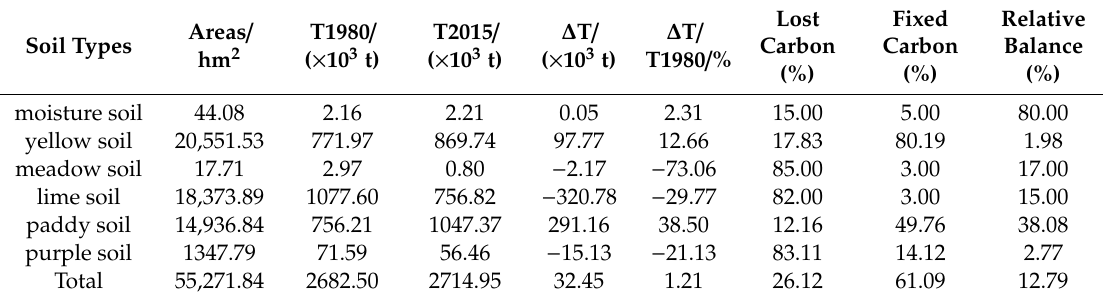
Table 6. Changes of SOC storage in surface soil of farmland in Puding County from 1980 to